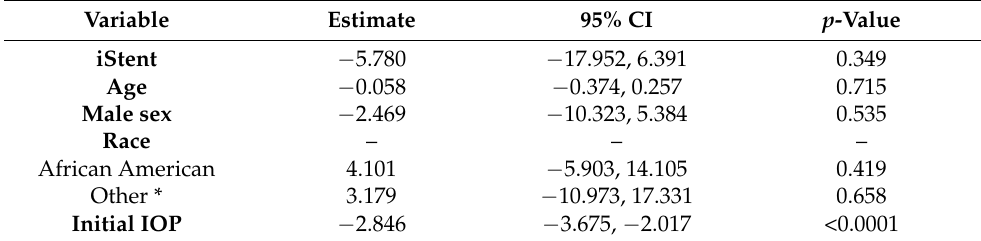
Table 7. IOP reduction complete multivariate.